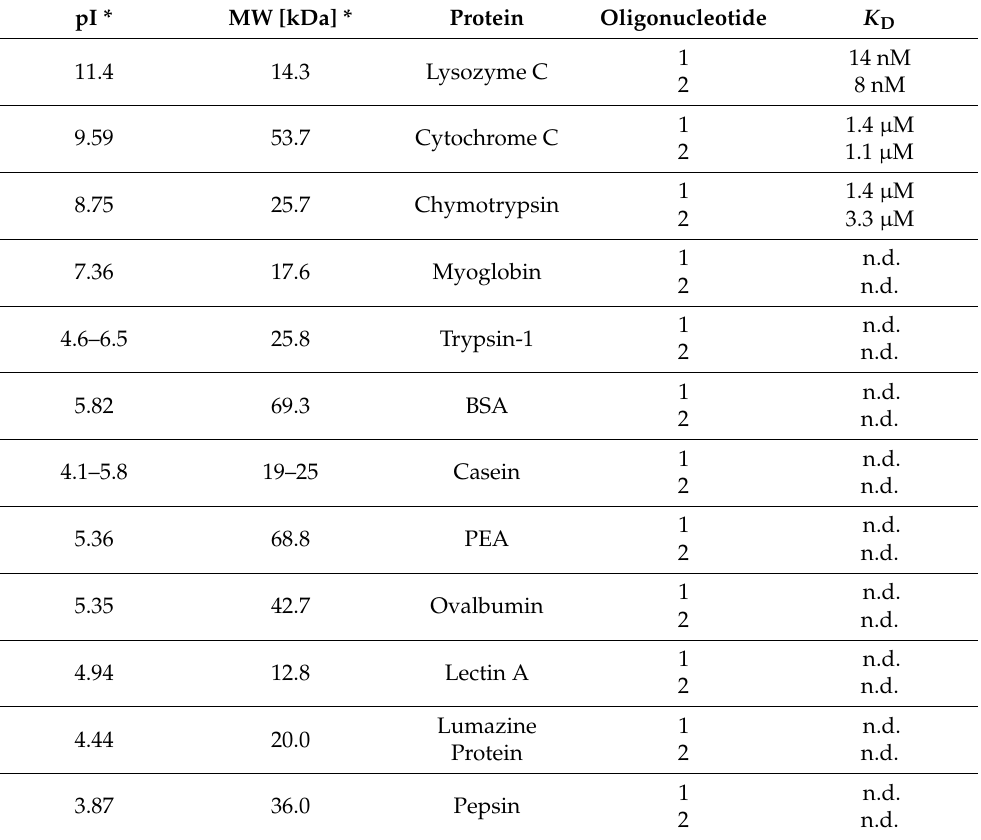
Table 1. Affinity of twelve proteins to two random oligonucleotides. N.d.: no binding determinable. pI * MW [kDa]